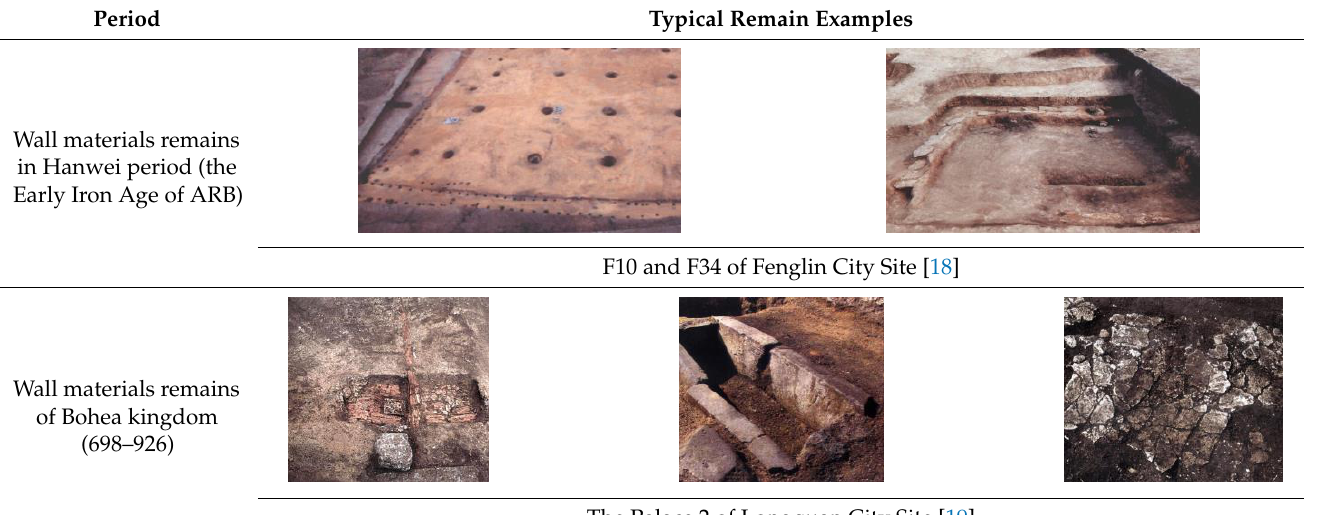
Table 2. The examples of material remains of walls in three periods [18–20,22].